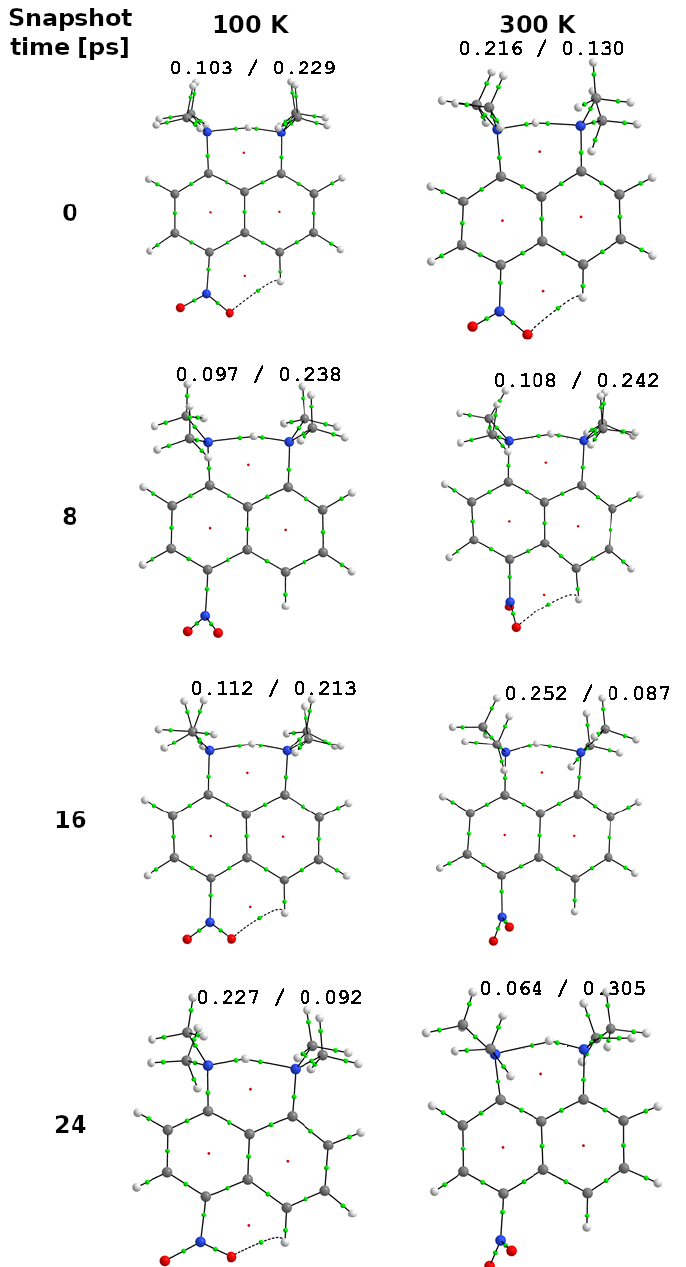
Figure 10. QTAIM molecular diagrams for compound (4) at 100 K and 300 K. Green dots represent bond critical points (BCPs) while red – ring critical points (RCPs). Values of electron densities at the left and right N-H BCPs are given in a.u. Color coding: red—oxygen; blue—nitrogen; gray—carbon;